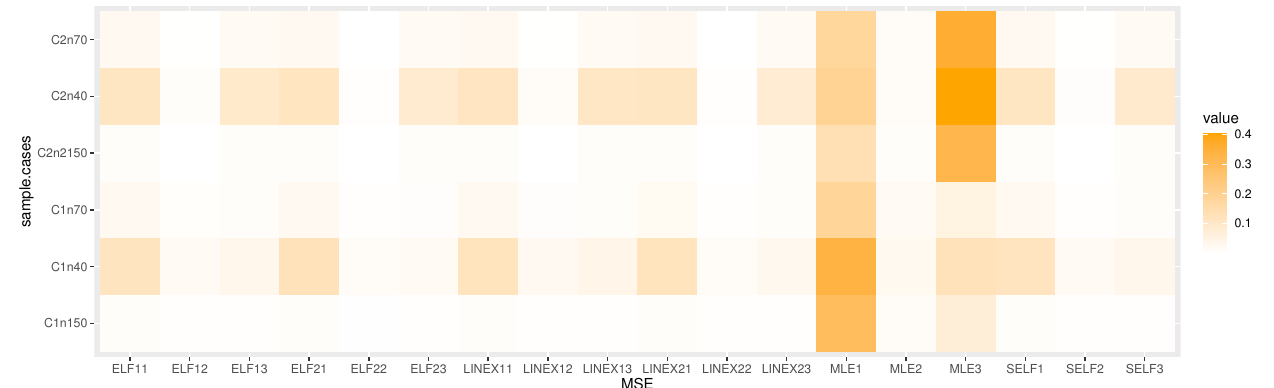
Figure 8. Heatmaps of MSE values for parameters of KMWE distribution with different sample cases: α = 0.5, β =